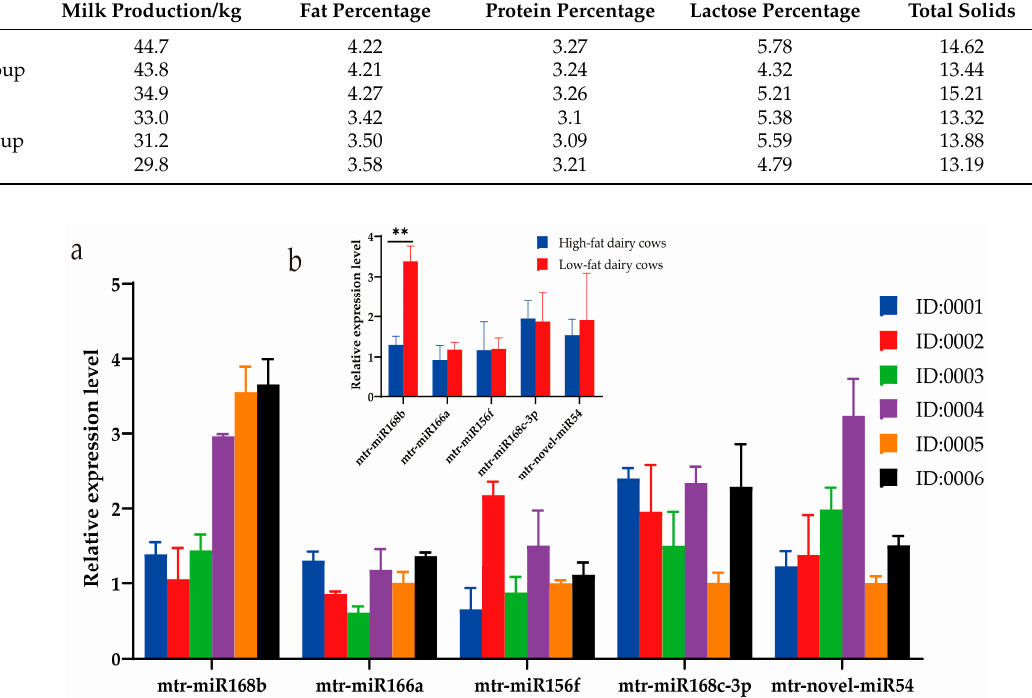
Figure 2. Relative expression of alfalfa miRNAs in bovine blood determined using qRT-PCR. Data are given as the mean ± SD for n = 3/group. ** p < 0.01 was considered statistically significant. ( a ) miRNA expression levels in blood and ( b ) significant difference in miRNA expression between high-fat-milk and low-fat-milk dairy cows.